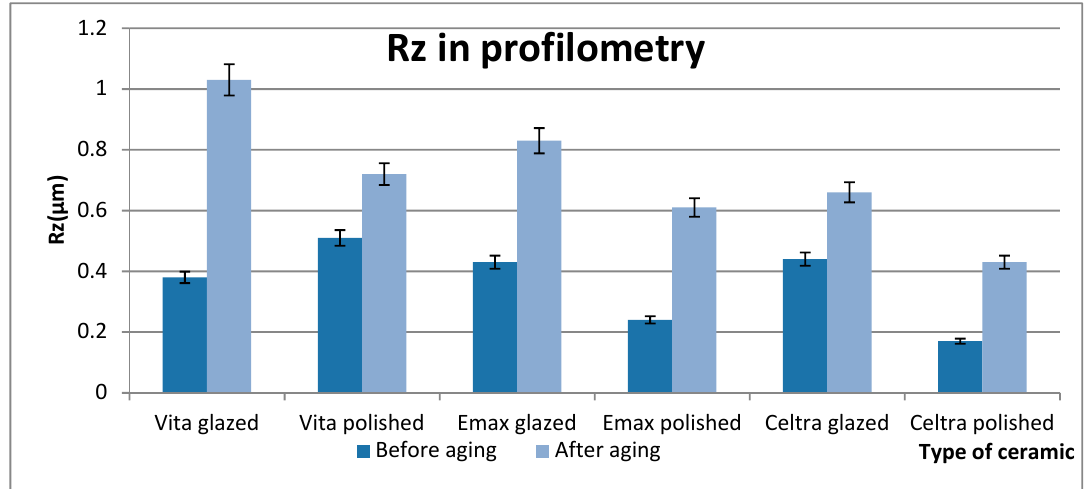
Figure 2. Mean and standard deviation values for maximum surface roughness before and after thermocycling.